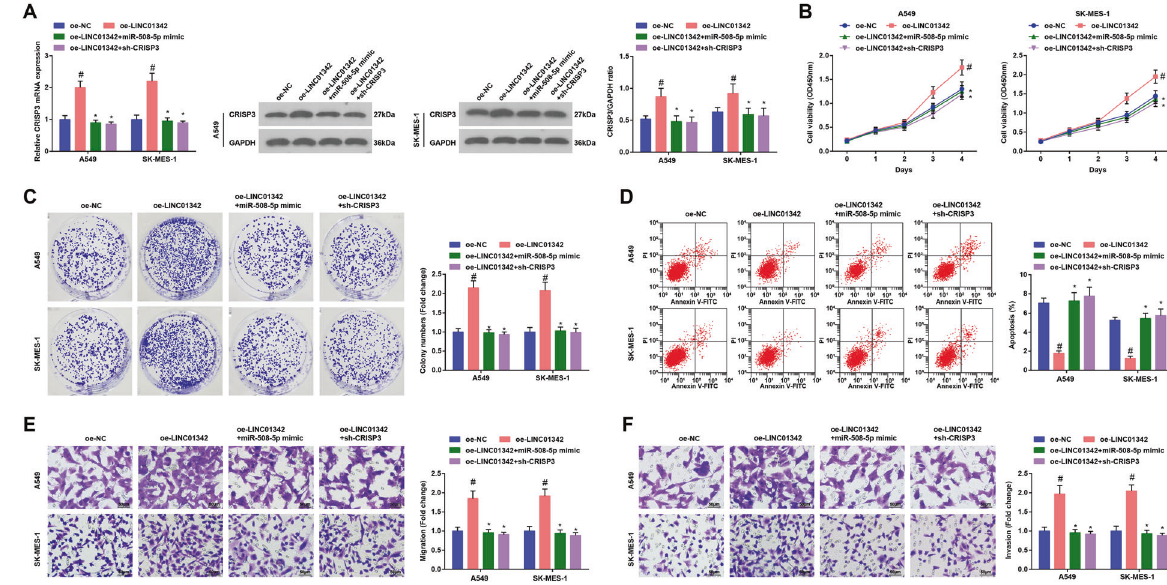
Fig. 7 LINC01342 promotes LC cell development through the miR-508-5p/CRISP3 axis. A CRISP3 mRNA and protein expression in LC cells was detected using RT-qPCR and Western blot analysis. B Cell viability was assessed using CCK-8 assay. C Colony formation ability of cells was detected using cell colony formation assay. D Apoptosis of cells was assessed using fl ow cytometry. E and F Migration and invasion of cells were detected using Transwell assay; # P < 0.05 vs. the oe-NC group; * P < 0.05 vs. the oe-LINC01342 group.